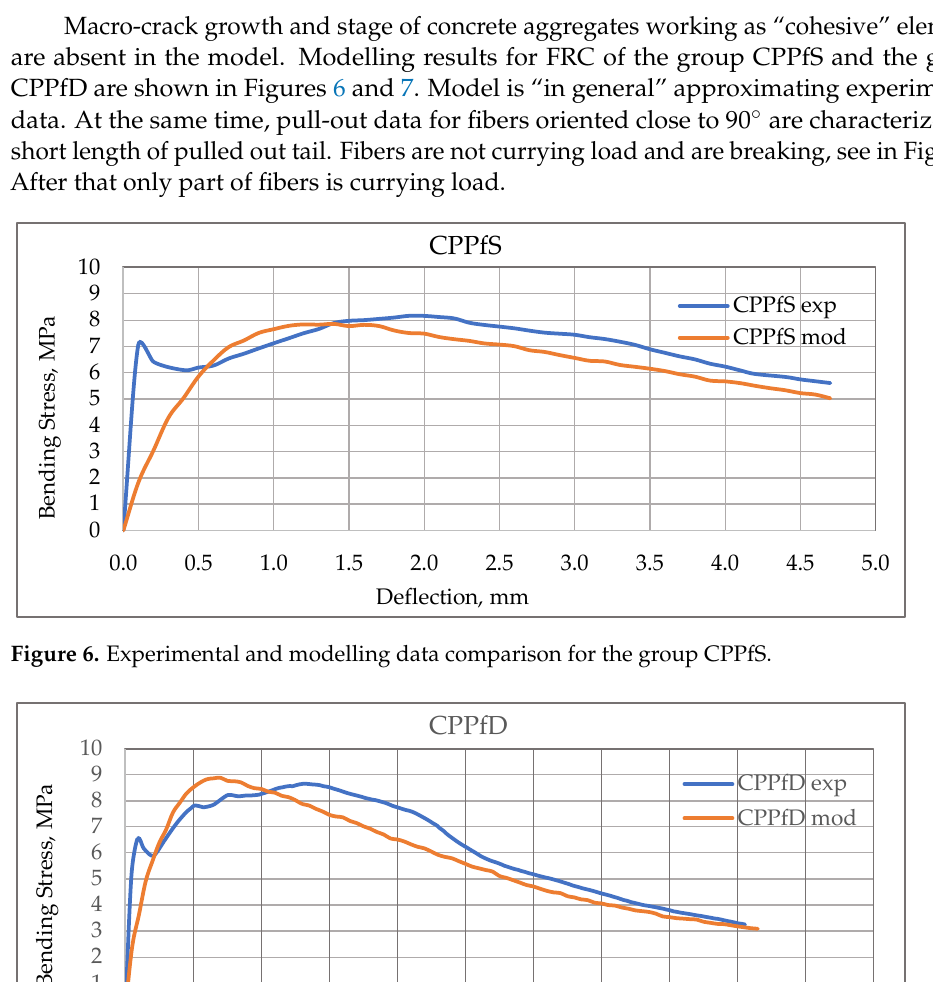
Figure 5. Experimental and modelling data comparison for materials in the group CSf.